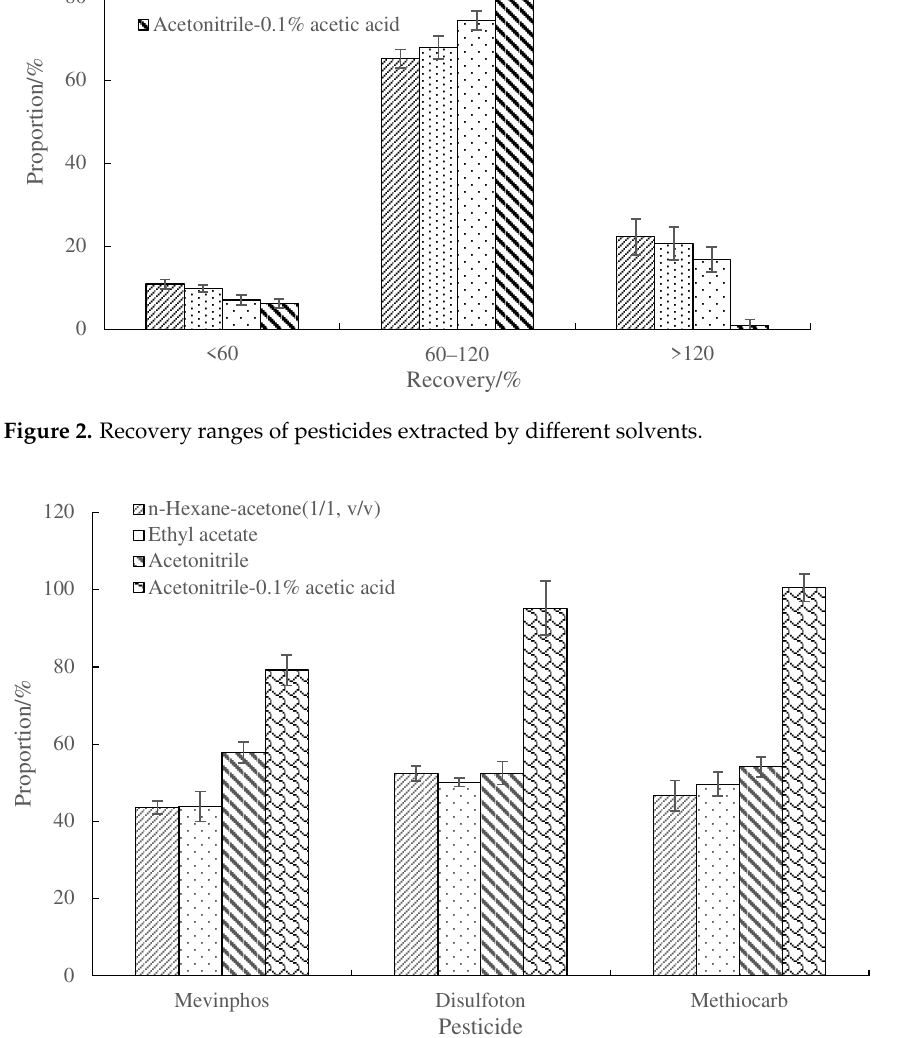
Figure 3. Recovery of three pesticides extracted by different solvents.